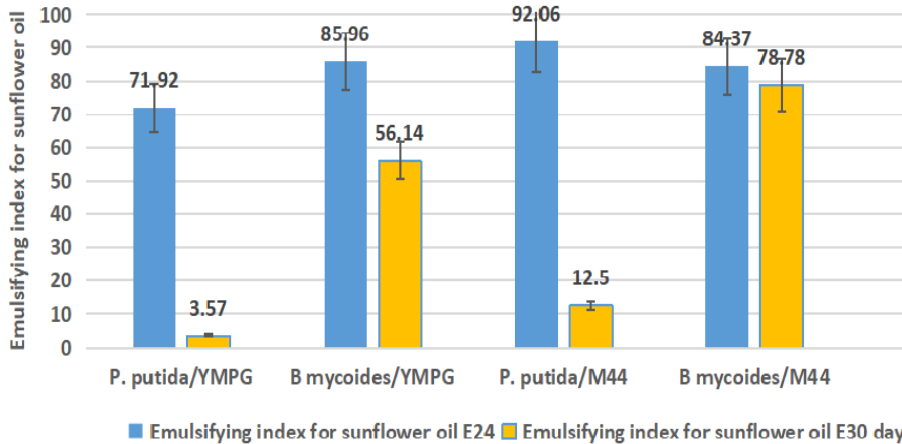
Figure 11. Emulsifying index for sunflower oil (YMPG and M44).